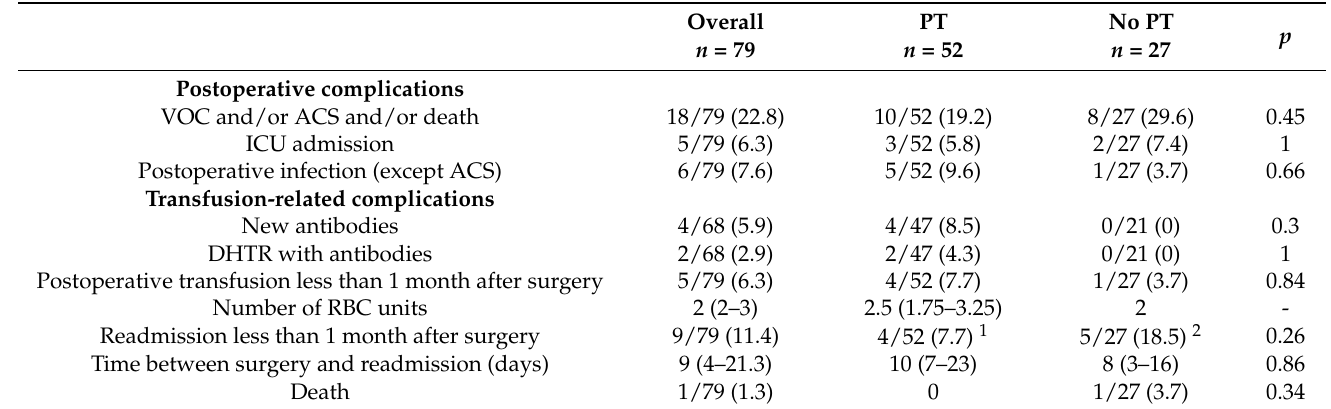
Table 2. Postoperative complications according to prophylactic